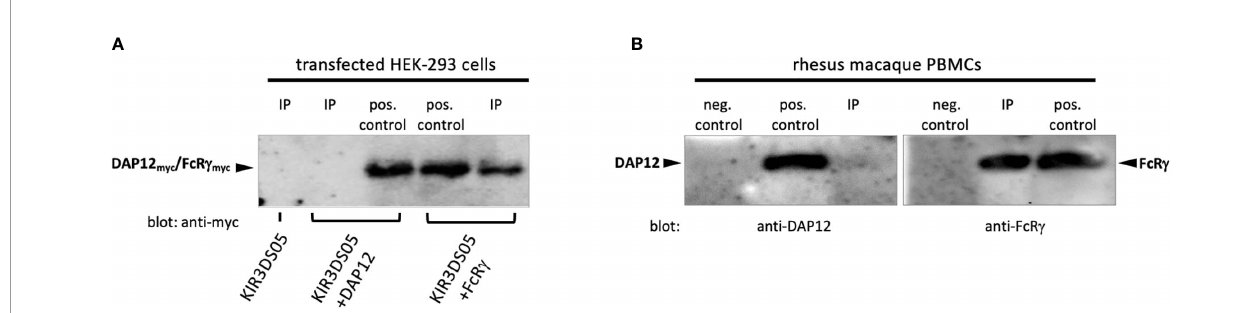
FIGURE 1 | Co-immunoprecipitation of adaptor proteins. (A) Immunoprecipitation of KIR3DS05 was performed with anti-rhesus macaque pan-KIR3D antibody 1C7 (26) as indicated (IP). As positive control we used cell lysates of KIR and adaptor protein-expressing cells. Anti-myc antibody was used in blots to detect myc-tagged FcR g and DAP12 adaptor proteins. A representative fi gure is shown from fi ve independent experiments. The molecular weight of rhesus macaque FcR g and DAP12 is 13.2 and 10.8 kDa, respectively, and the size difference is hardly detectable in the western blot analyses. (B) Lysates of rhesus macaque PBMCs were used directly (pos. control) or were subjected to immunoprecipitation with antibody 1C7 (IP). Detection of adaptor proteins in western blots was performed with anti-FcR g and anti-DAP12 polyclonal antibodies. To control for unspeci fi c binding of the polyclonal anti-adapter protein antibodies in western blot, we used FcR g and DAP12 negative cells (untransfected HEK-293 cells; neg. control). The results from one out of two independent experiments are